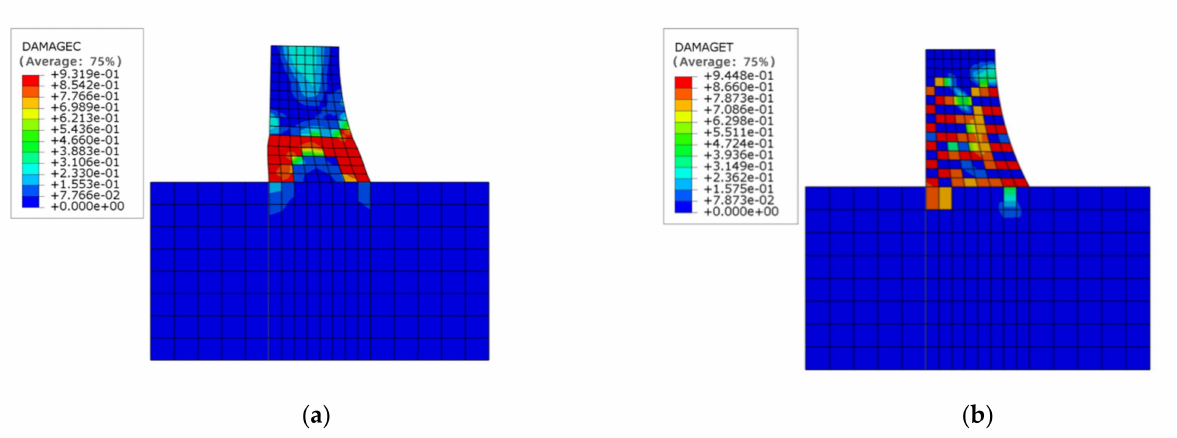
Figure 18. Cloud images of concrete damage. ( a ) Cloud image of concrete damage under compression. ( b ) Cloud image of concrete damage under